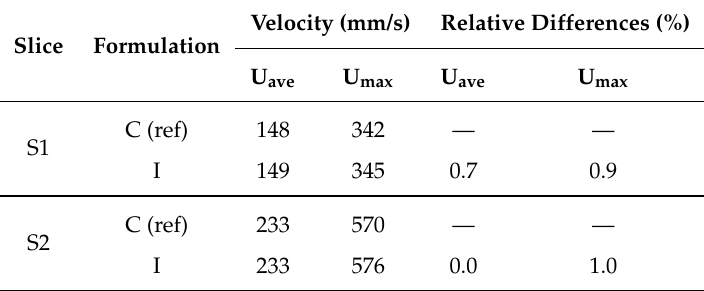
Table 9. Average and maximum velocity magnitude values for slices S1 and S2 (see Figure 4), at the switch-over